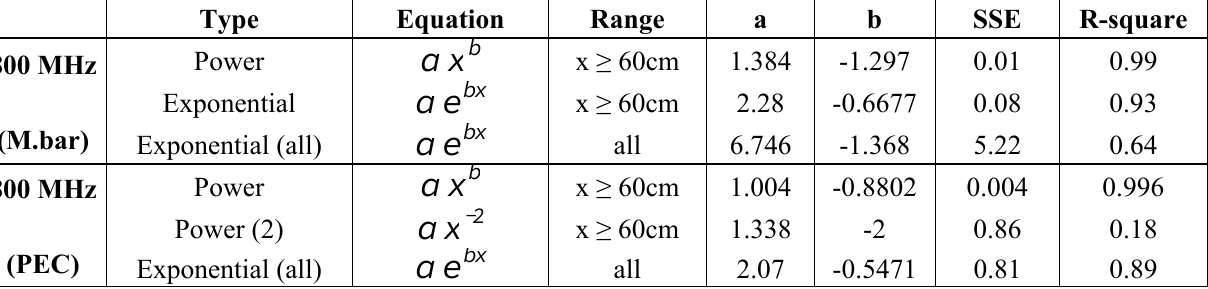
Table 5 . Values that allow the best fit of the regression curves for the 800 MHz antenna. Measurements were obtained with high stacking (512) to ensure adequate signal stability. Concerning the quality of the fit, sum of squared errors (SSE) and correlation coefficient (R-square) parameters are included in the